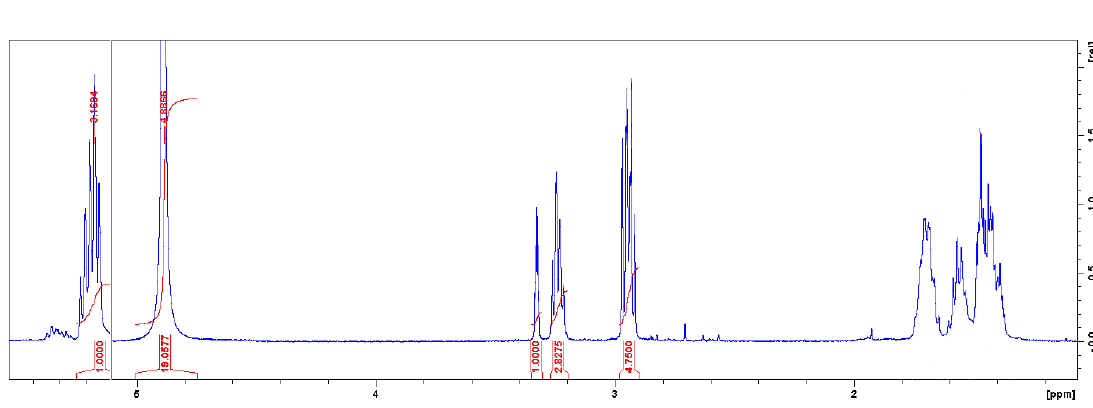
Figure 3. NMR spectrum of polymer -isomer a- (dissolved in CD 3 COCD 3 ).